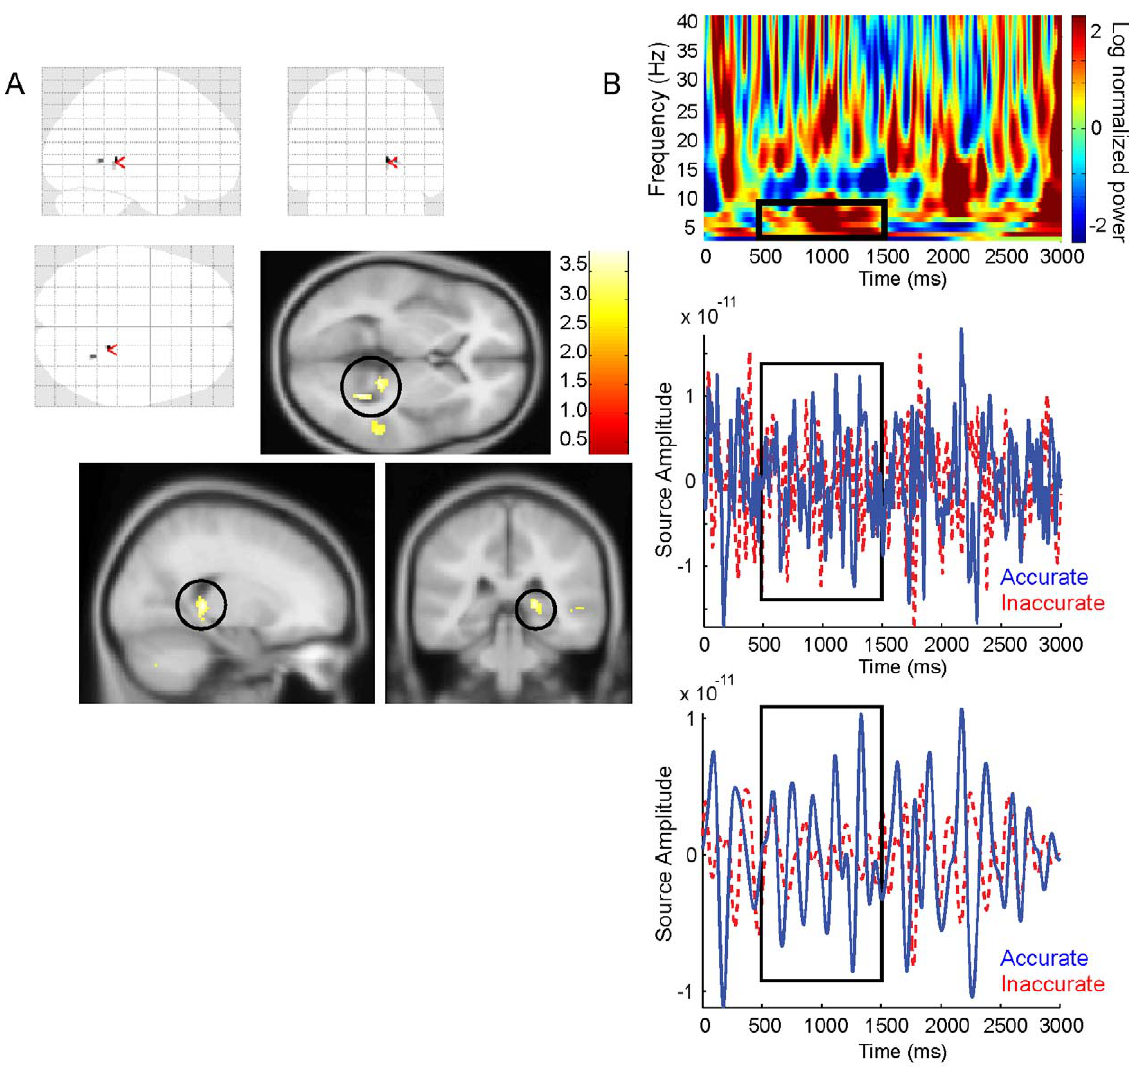
Figure 5. MEG source reconstruction of performance-related theta during the cue phase. (A) Top: ‘‘Glass brain’’ showing performance- related posterior right hippocampal source in the 4–8 Hz theta band from 500–1,500 ms within the 3-s Cue Period, which were the only significant sources of theta in the whole brain (peak-voxels: x=18; y= 2 36; z=4; Z-score=3.26, highlighted by red arrows and x=26, y= 2 50, z=4; Z- score=3.19, thresholded at p , .001, see Figure 3A–B for corresponding sensor-level plots). Bottom: Hippocampal sources shown overlaid on the SPM8 canonical average MNI 152 T1 image, significance threshold at p , .005 for display purposes. (B) Top: Single participant spectra from beamformer source extraction of a virtual sensor in right posterior hippocampus (x=18; y= 2 36; z=4). The black box shows the window used for the LCMV beamformer (500–1,500 ms; 4–8 Hz). Middle: Representative traces from the same participant and site for accurate trials (blue) and inaccurate trials (red). Bottom: Filtered versions of the traces (3.5–8 Hz). Source Amplitude and Power for these source extractions are measured in Ampere Meters.